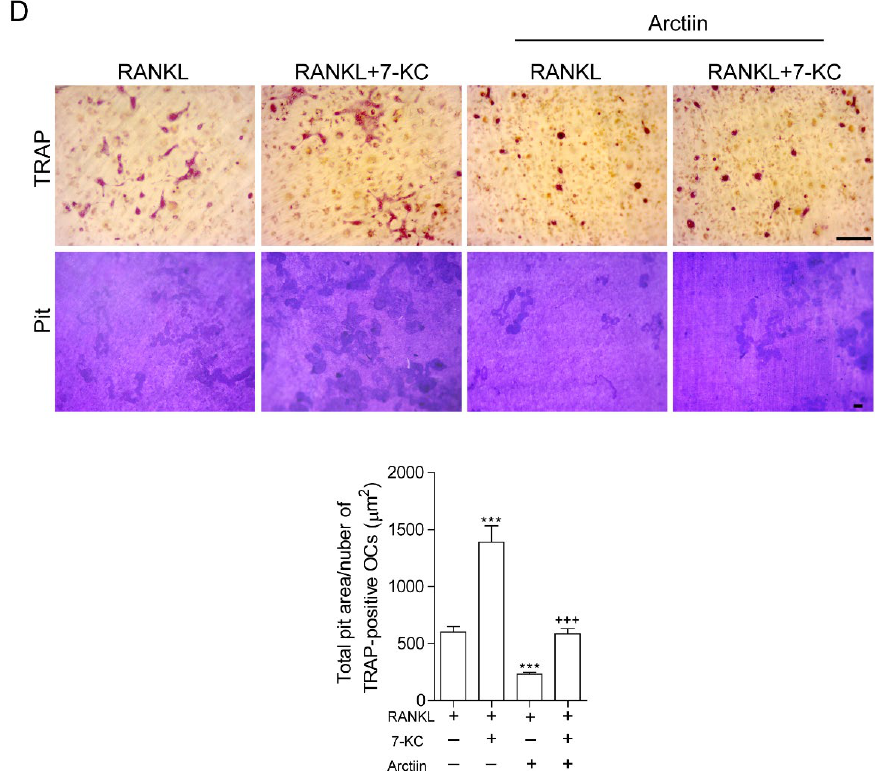
Figure 2. Arctiin decreases the number and activity of osteoclasts that are augmented by 7-KC. ( A ) BMMs were incubated with M-CSF (30 ng/mL) and RANKL (40 ng/mL) in the presence or absence of 7-KC (7 µ M) or arctiin (10, 15, 20 µ M) for 65 h ( n = 3). After TRAP staining, the area (bold line), maximum diameter (double arrow), fusion index, and number of OCs were measured. Representative photos are shown (scale bar: 200 µ m). ( B ) Cell viability was measured via the MTT assay ( n = 5). ( C ) RNA from cells stimulated with M-CSF (30 ng/mL) and RANKL (40 ng/mL) in the presence or absence of 7-KC (7 µ M) or arctiin (15 µ M) for 65 h was analyzed by qPCR ( n = 4). The expression level before RANKL treatment was set to 1. ( D ) Mature OCs were further incubated on whole dentine slices with M-CSF (30 ng/mL) and RANKL (40 ng/mL) in the presence or absence of 7-KC (7 µ M) or arctiin (15 µ M) for 4–5 d ( n = 3). Representative photos of TRAP-positive OCs (scale bar: 200 µ m) and resorption pits (scale bar: 50 µ m) are shown. The total pit area/number of TRAP-positive OCs was calculated. $ p < 0.05; $$ p < 0.01; $$$ p < 0.001 compared with BMMs. * p < 0.05; *** p < 0.001 compared with RANKL-treated cells. + p < 0.05; ++ p < 0.01; +++ p < 0.001 compared with RANKL and 7-KC-treated cells. Similar results were obtained in three independent sets of